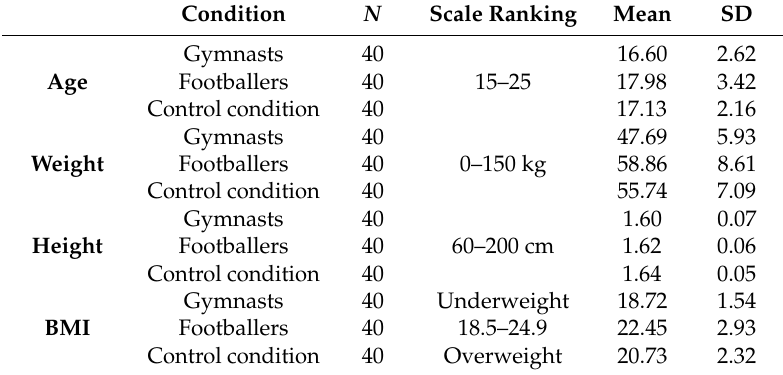
Socio-demographic factors